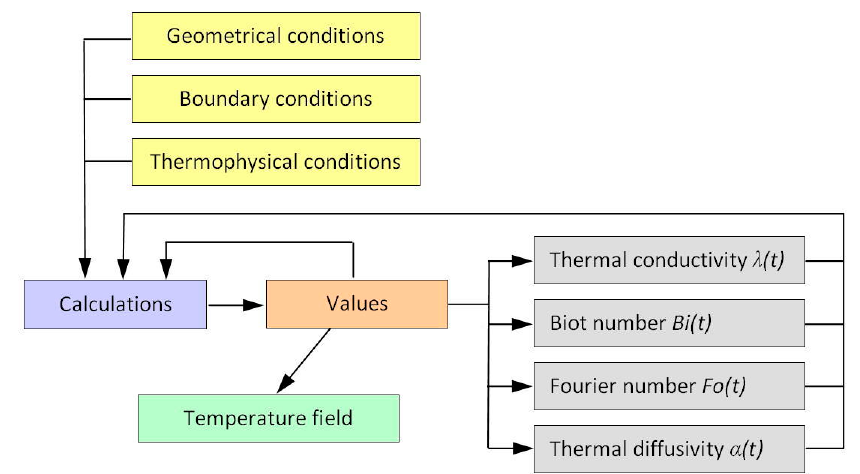
Figure 3. Calculation algorithm in the finite difference method (FDM).